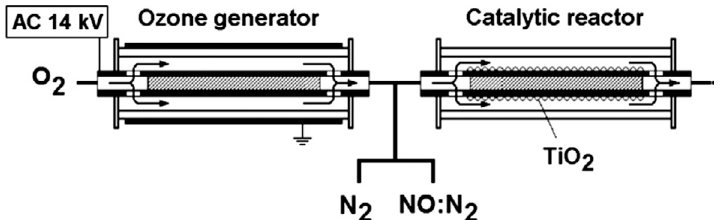
Figure 6. Experimental apparatus for indirect plasma treatment of NO x . Reproduced with permission from [100], Elsevier, 2022.